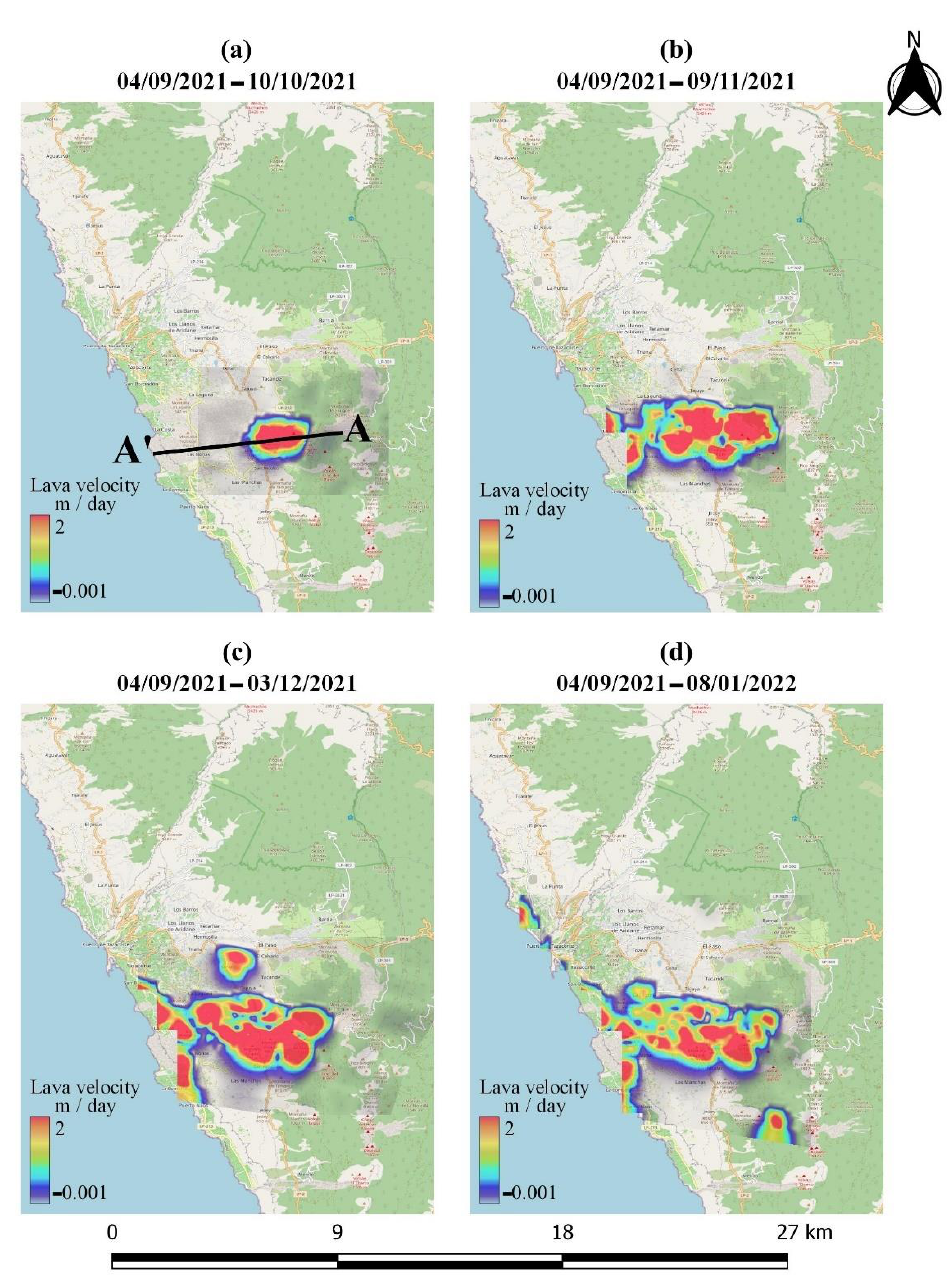
Figure 11. Lava flow evolution, obtained by processing the Sentinel-1 descending data through off-set tracking.